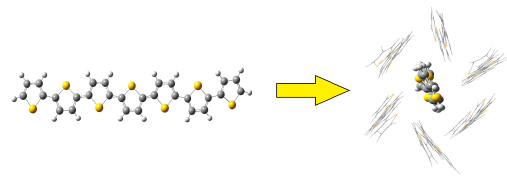
Figure 2. The schematic illustration of the QM/MM methodology.